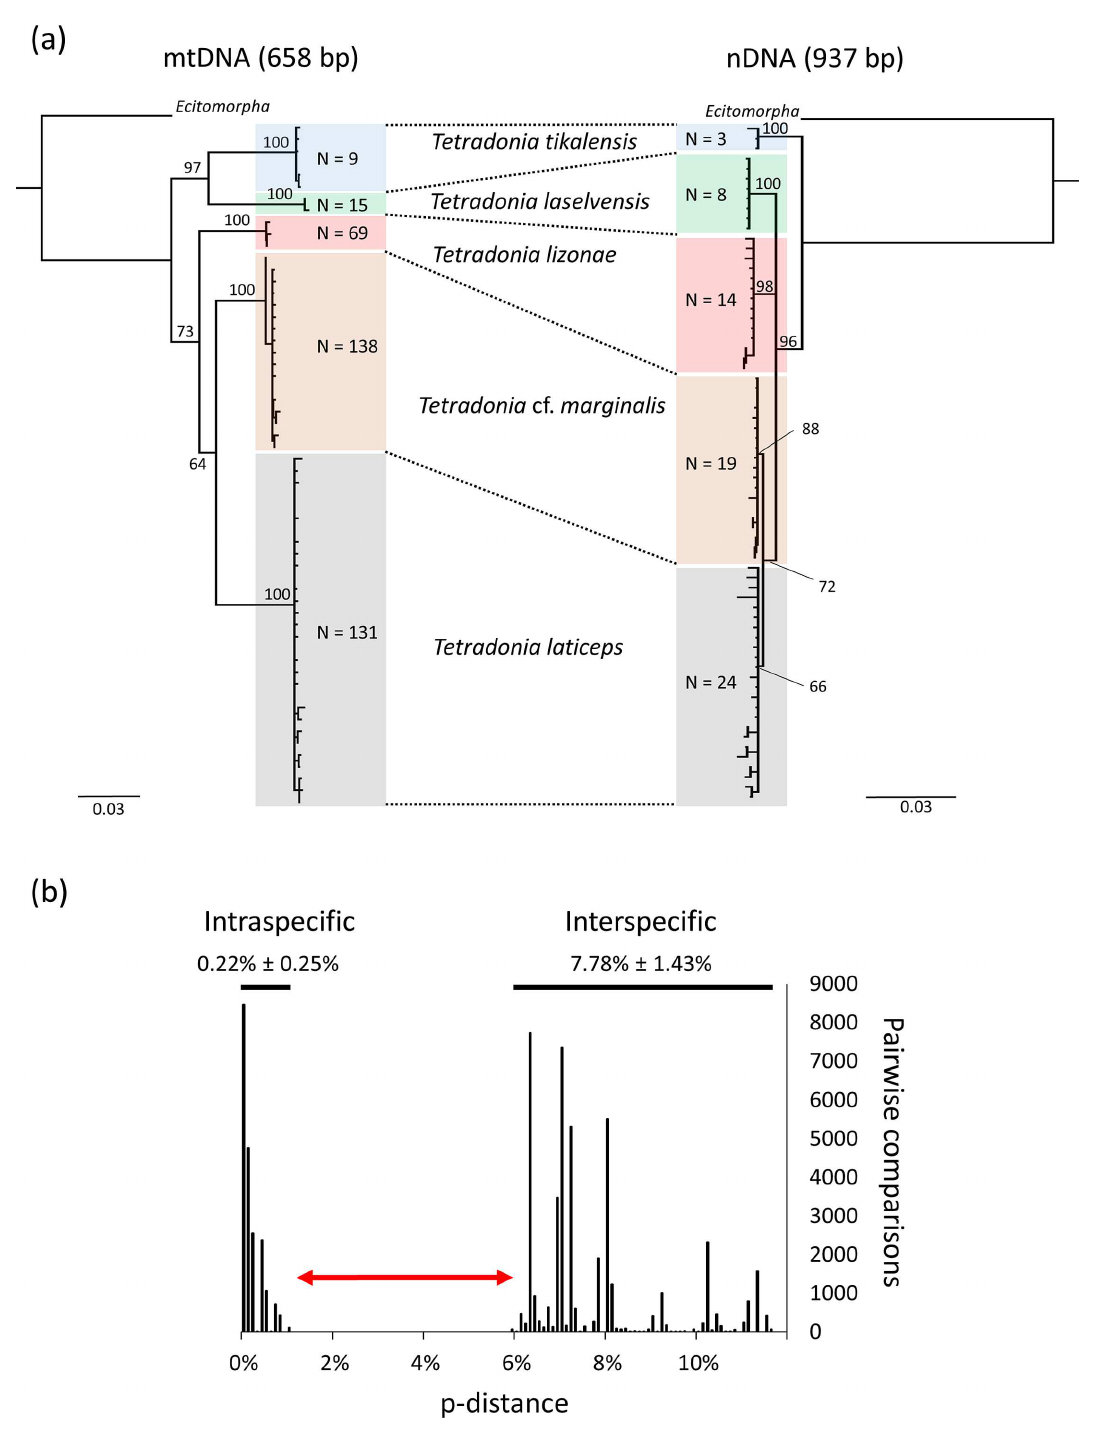
Fig 2. Genetic assessmentof species boundaries in a community of Tetradonia beetles. (a) NJ trees based on Tamura-Nei distances (scale bars) for both mitochondrial ( COI sequences, left) and nuclearDNA sequences (concatenated wg and CAD sequences, right) reveal the same five genetic clusters (i.e. candidate species), which are depicted by separatelycolored boxes. Ecitomorpha arachnoides (Staphylinidae: Aleocharinae: Ecitocharini), collected in an emigrationof Eciton burchelliiforeli , served as outgroup. Numbers in boxes show the numbers of analyzedspecimens. Bootstrap support values (1,000 replicates) for major nodes are shown. (b) Histogram showingintra- and inter-specific p- distances between Tetradonia mitochondrial COI sequences. P-distances give the proportionof bases that differ